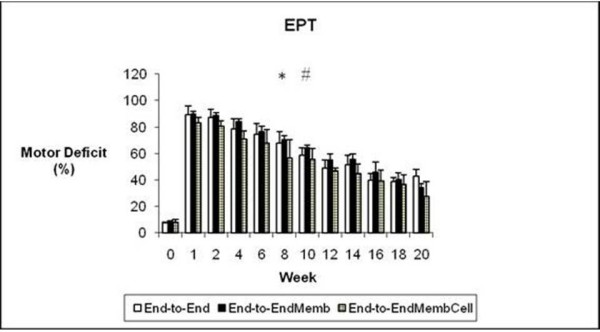
Weekly values of the percentage of motor deficit obtained by the Extensor Postural Thrust (EPT) test. * Significantly different from week-0 all groups pooled together (p < 0.05). # Group End-to-EndMembCell significantly different from the other groups (p < 0.05). Results are presented as mean and standard error of the mean (SEM).